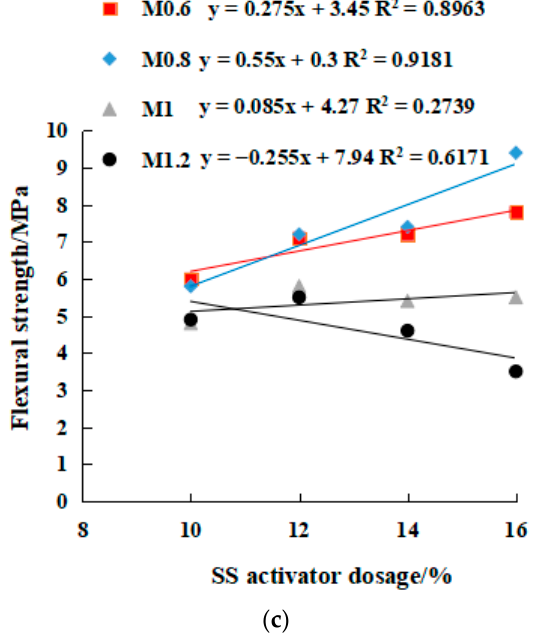
Figure 11. Relationship between flexural strength and SS activator dosage. ( a ) 3 days, ( b ) 7 days, ( c ) 28 days. y = ax + b, where y is the compressive or flexural strength, MPa. x is SS activator dosage, and 10 ≤ x ≤ 16%. a and b are constants.